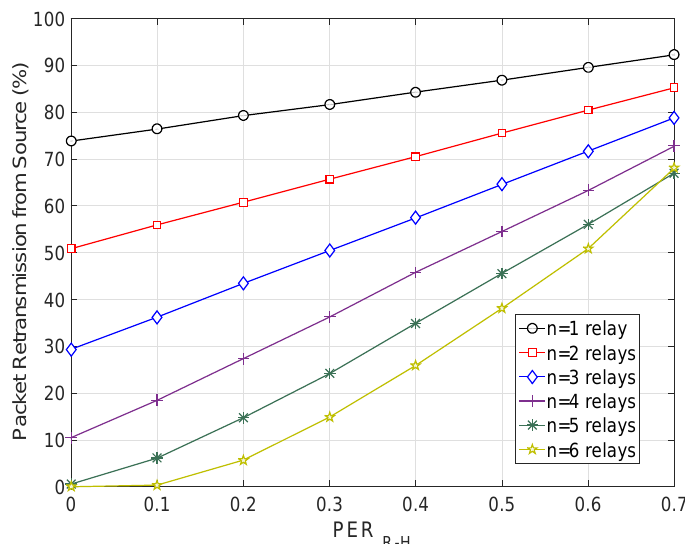
Figure 5. Percentage of retransmissions by the source in the baseline cooperative IEEE 802.15.6 (Coop802.15.6) scheme.